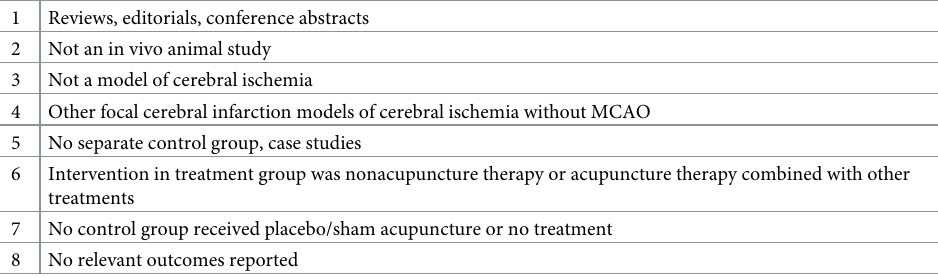
Table 2. Exclusion criteria order of